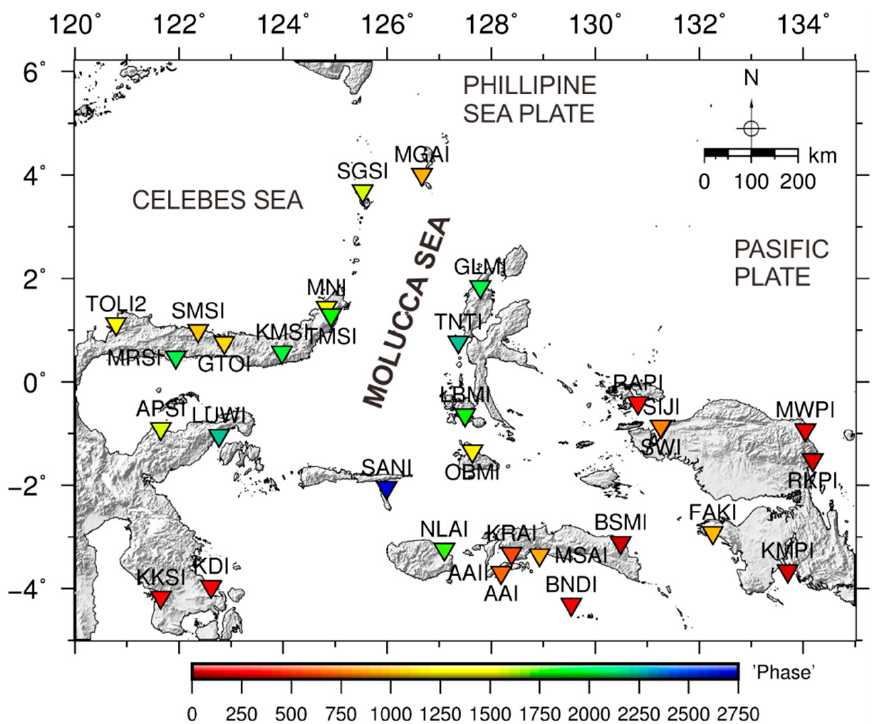
Figure 2. Arrival times distribution of P-and S-wave for all stations. Colored inverted triangles denote the number of phases per station.